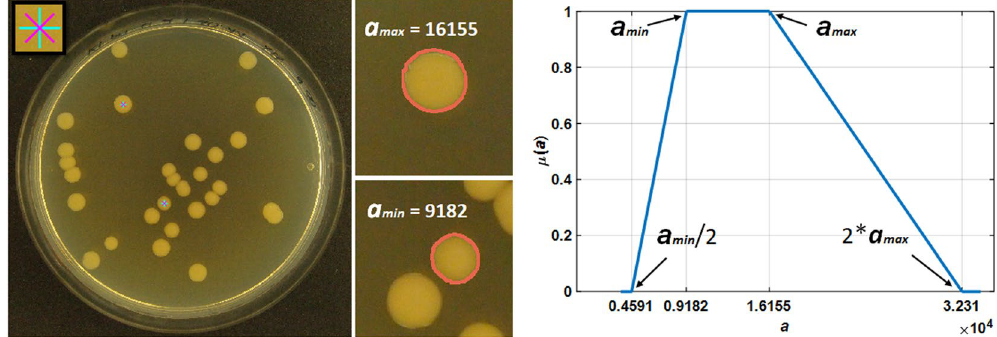
Figure 6. The extraction process of a priori information from the AutoCellSeg GUI. The asterisk sign on the top left corner of the full RGB image shows the selection marker. The initial colonies could be selected by left- clicking of the mouse. The two colonies selected in the full RGB are indicated by the asterisk signs. The two smaller images in the middle show the detection of these colonies using the fast marching method (indicated by the pink colored delineation). The maximum and minimum colony sizes are then used for the extraction of a priori knowledge as shown in the graph on the right where μ ( a ) (fuzzy membership function) is on y-axis and a (colony sizes) is on x-axis. The edges of the trapezoid are indicated by black arrows. The edges have the values (0.5 a min , a min , a max , 2 a max ) = (4591, 9182, 16155,